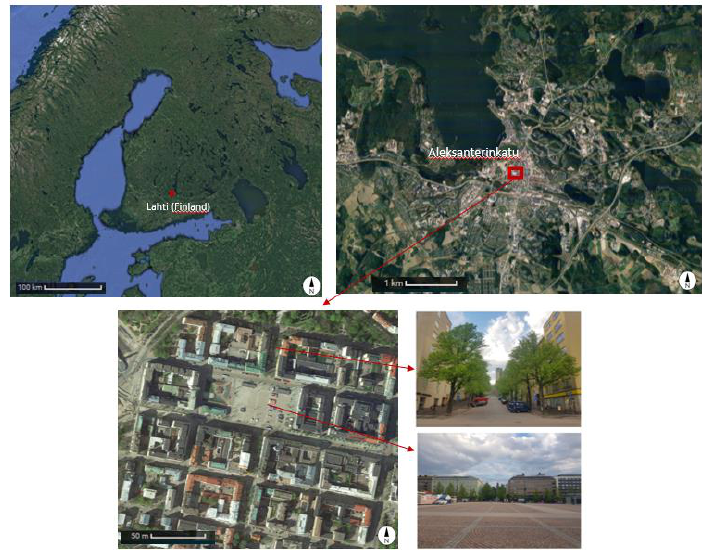
Figure 2. Top: position of the city of Lahti located in southern Finland with a focus on the study area located in the city centre (referred to as Aleksanterinkatu hereinafter. Bottom: 3D view of Aleksanterinkatu neighbourhood (modified from Google Earth) and street pictures showing Tilia cordata Mill. and the square.